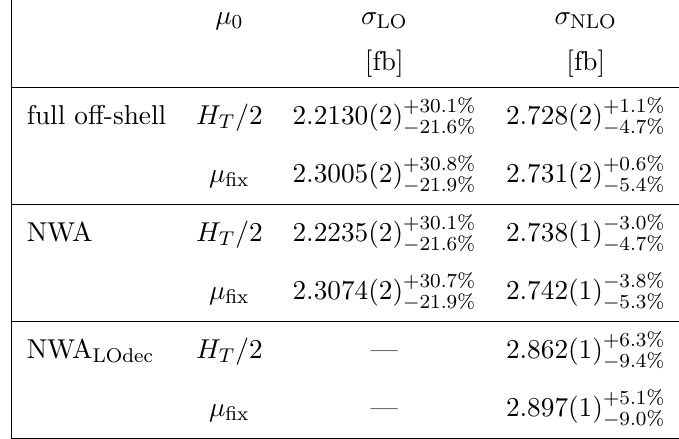
Table 4 . Integrated fiducial cross section at LO and NLO QCD for the pp → e + ν e µ − ¯ ν µ b ¯ b H √ process at the LHC with s = 13 TeV. Results for three different approaches, full off-shell case, NWA and NWA LOdec , are shown. Theoretical predictions are given for µ 0 = H T / 2 and µ 0 = µ fix . The NNPDF3.1 PDF set is